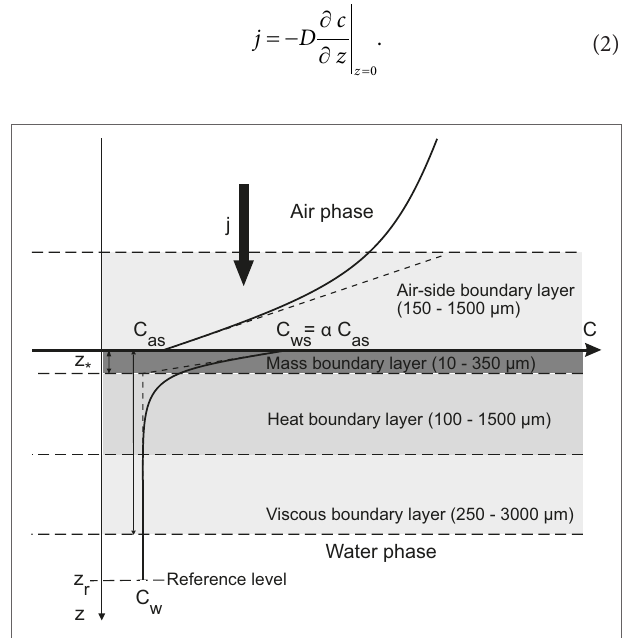
FigURe 1 | Sketch of the boundary layers at the air–sea interface and the mean vertical profile under steady-state conditions for a chemical species with a dimensionless solubility α (partitioning coefficient) of 3, being transported from the atmosphere into the ocean.